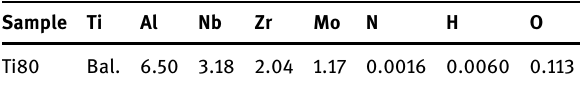
Table 1: The chemical composition of Ti80 alloy ( mass fraction, % )